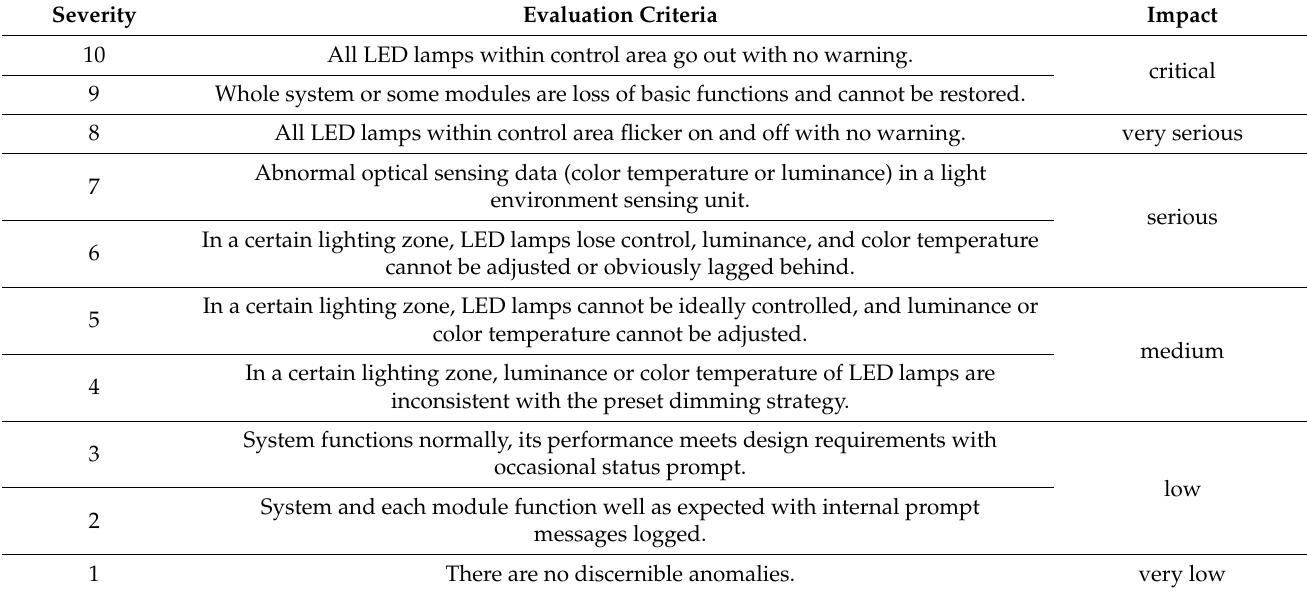
Table 7. Evaluation criteria for FMEA severity